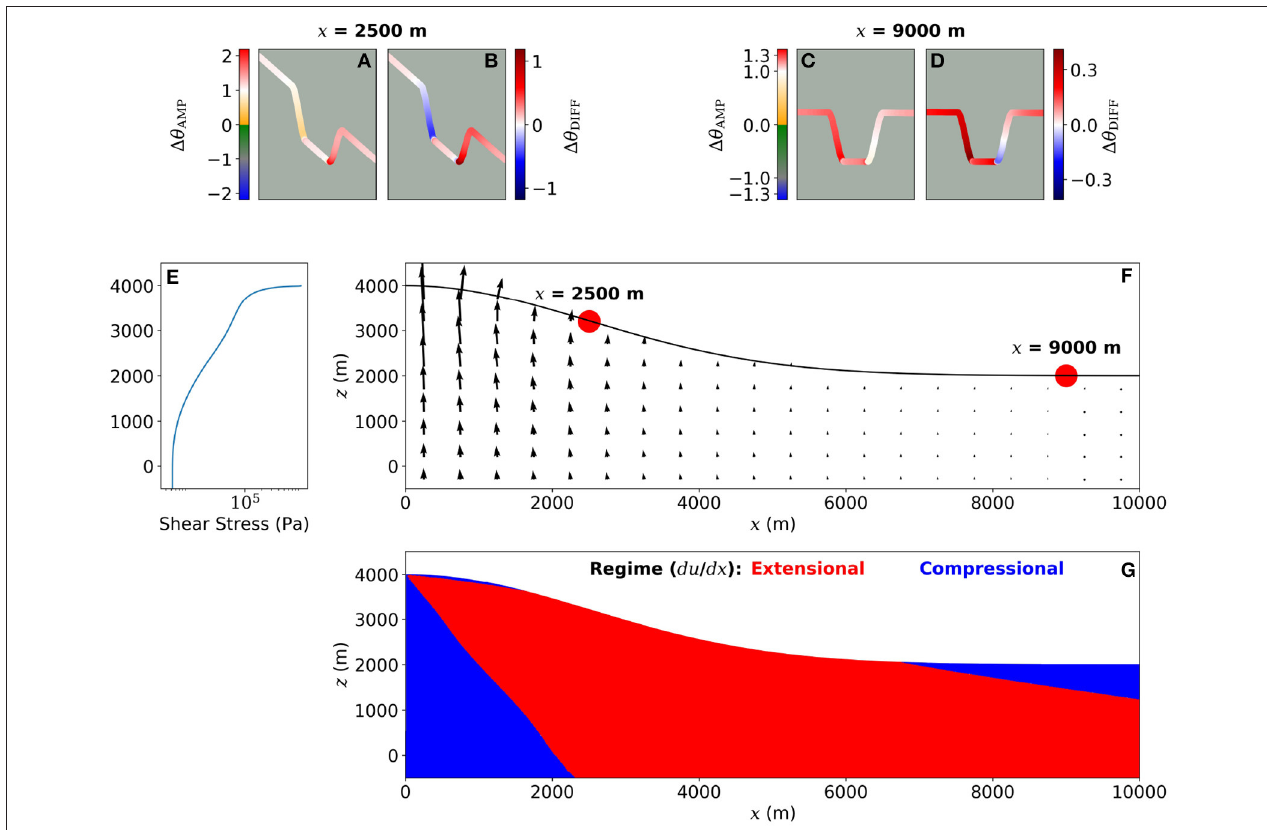
FIGURE 6 | (A–D) Amplification factor and difference due to the topographic effect on tilt produced by shear stress, where opposing slopes are included at either x = 2,500 or 9,000 m, as indicated by red dots. (E) Depth variant shear stress profile from flow modeling of Marsden et al. (2019). (F) Amplitude and orientation of the displacement field produced by shear stress. (G) du / dx , red where positive and horizontal displacement is increasing with increasing x , and so the horizontal distance between points is increasing (extension), blue where negative and the horizontal distance between points is decreasing